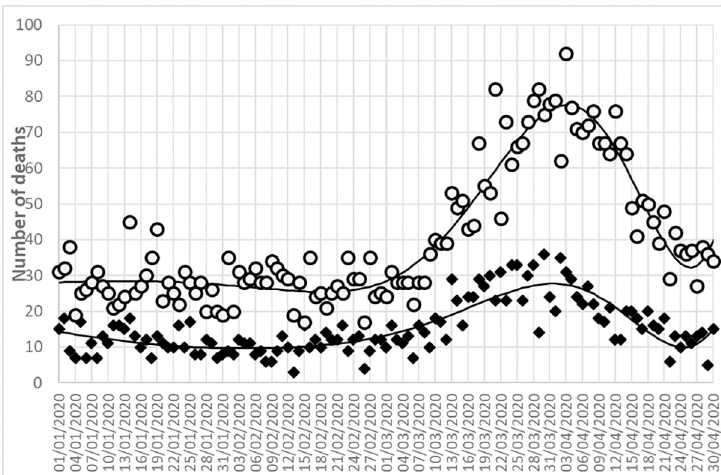
Fig 1. Number of deaths in 2020 according to age class. White dots represent the daily deaths of patients aged � 80 y, black diamonds represent the daily deaths of patients < 80 y. Solid lines represent trends among the data.